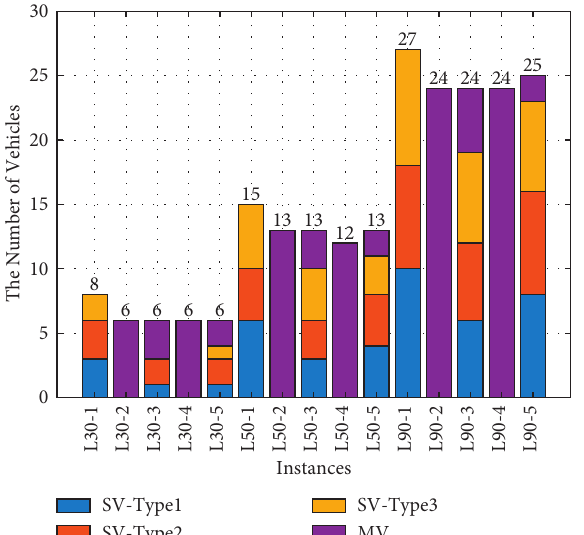
Figure 6: Vehicle configurations of large-scale instances.